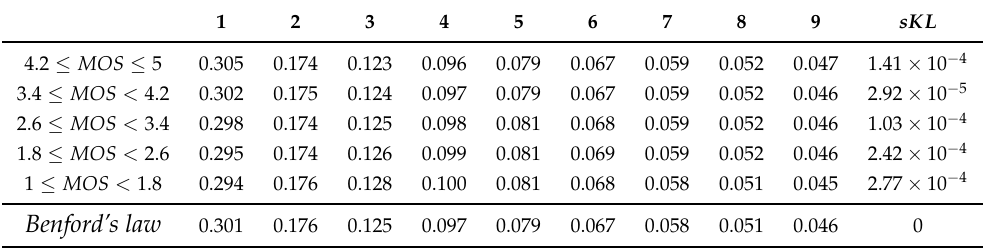
Table 6. Mean FDD of 3D DCT coefficients in KoNViD-1k [22] with respect to different MOS intervals. In KoNViD-1k [22], the lowest possible video quality is represented by MOS = 1.0, while MOS = 5.0 stands for the highest possible video quality. In the last column, the symmetric Kullback–Leibler ( sKL ) divergences between the actual FDD and the Benford law distribution are